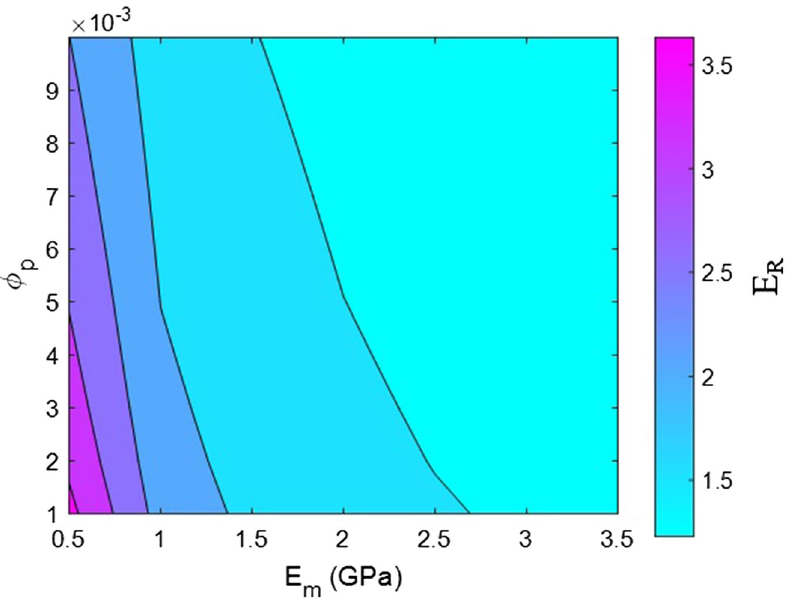
Figure 7. Estimates of relative modulus assuming various matrix moduli and percolation onset according to the current